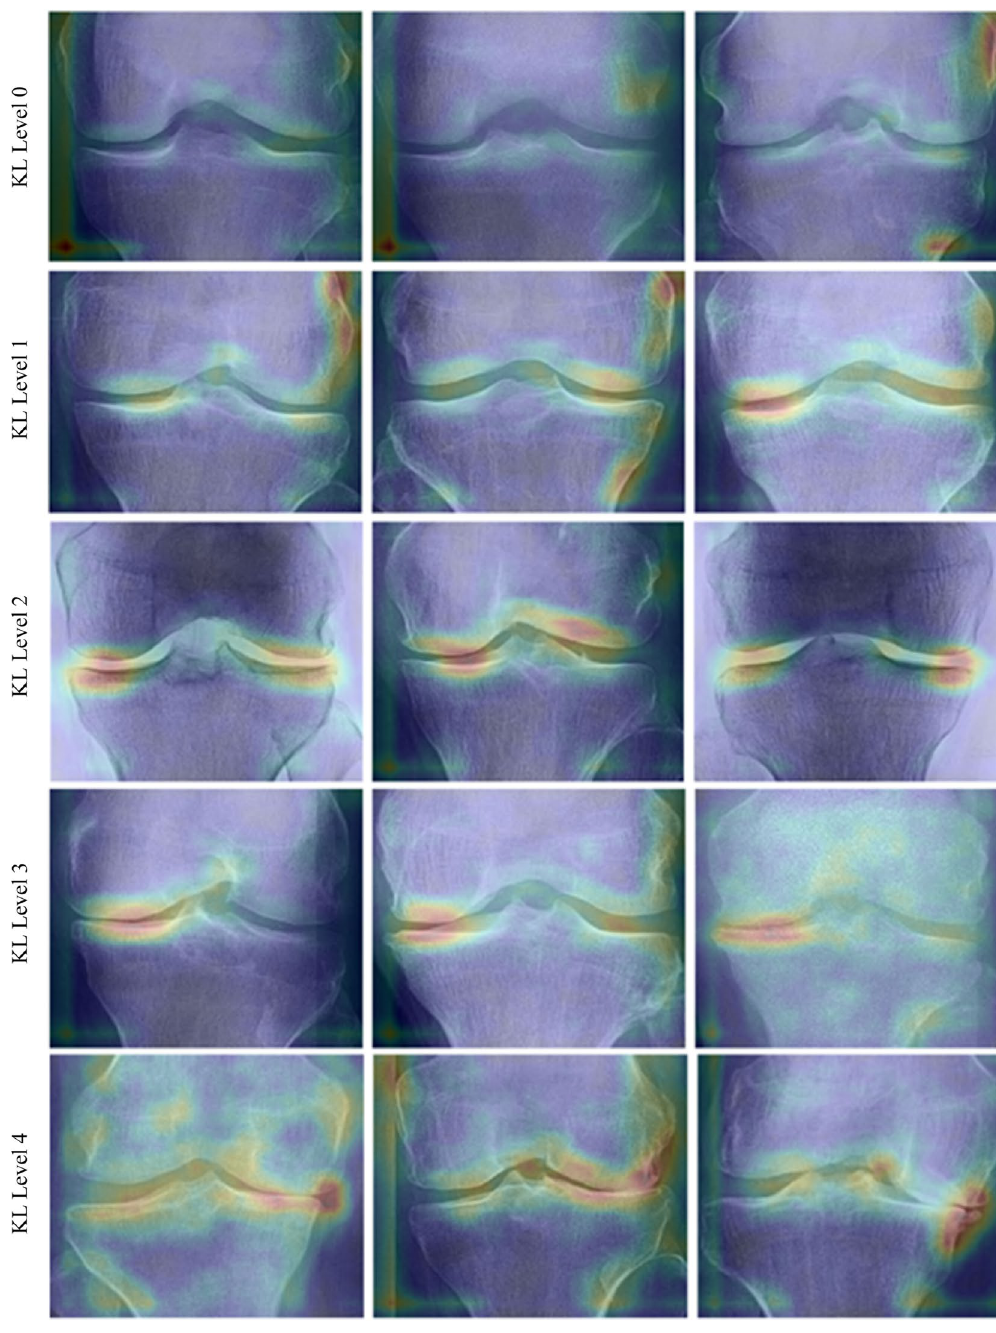
Figure 4. Ensemble CNN prediction explanations produced using Eigen-CAM for three sample images for different severity